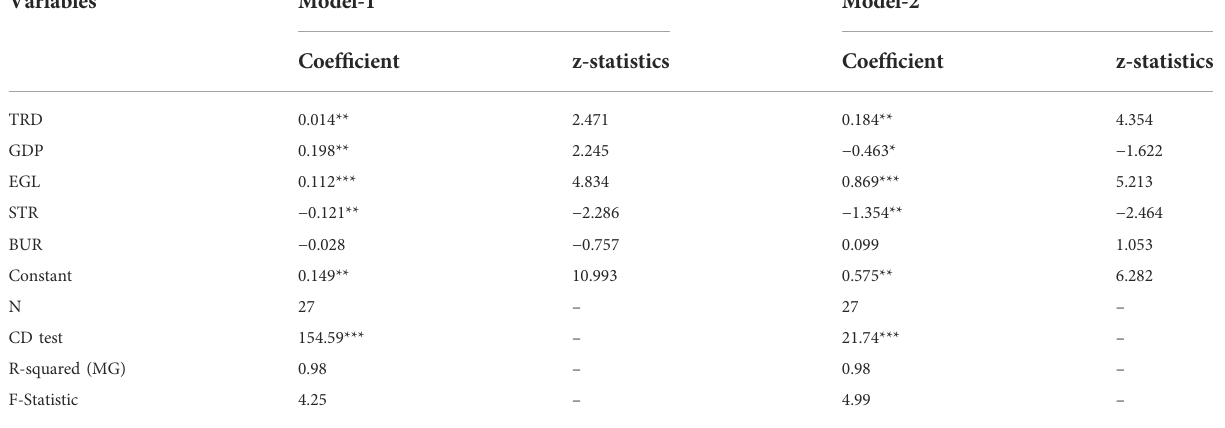
TABLE 6 Panel Empirics using CS-DL Estimations (Mean